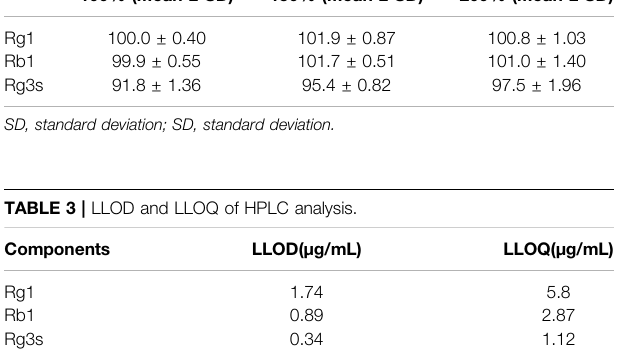
SD, standard deviation; RSD, releative standard deviation.